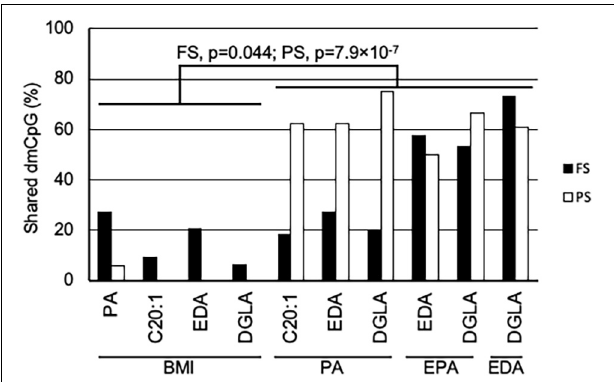
FIGURE 2 | Shared dmCpG between BMI and FA. Percentage of shared dmCpG between BMI and FA, or among FA in FS (solid bars) and PS (open bars). Percentages were calculated of FA dmCpG counts in BMI-FA comparisons, or of the lowest dmCpG counts in FA-FA comparisons. FS and PS, fasting and postprandial state, respectively. Significance of differences between the percentage of dmCpG shared by BMI and FA and shared by FA is shown in FS and PS (Mann–Whitney U -test).